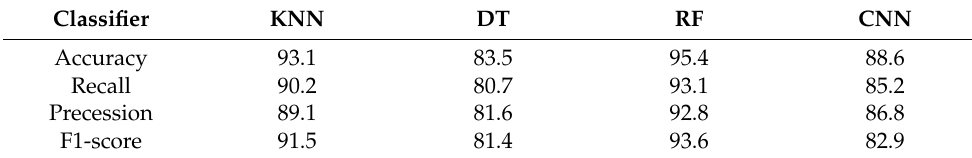
Table 7. Phase 2: Anomaly detection results in Scenario B: single point-and-click action.